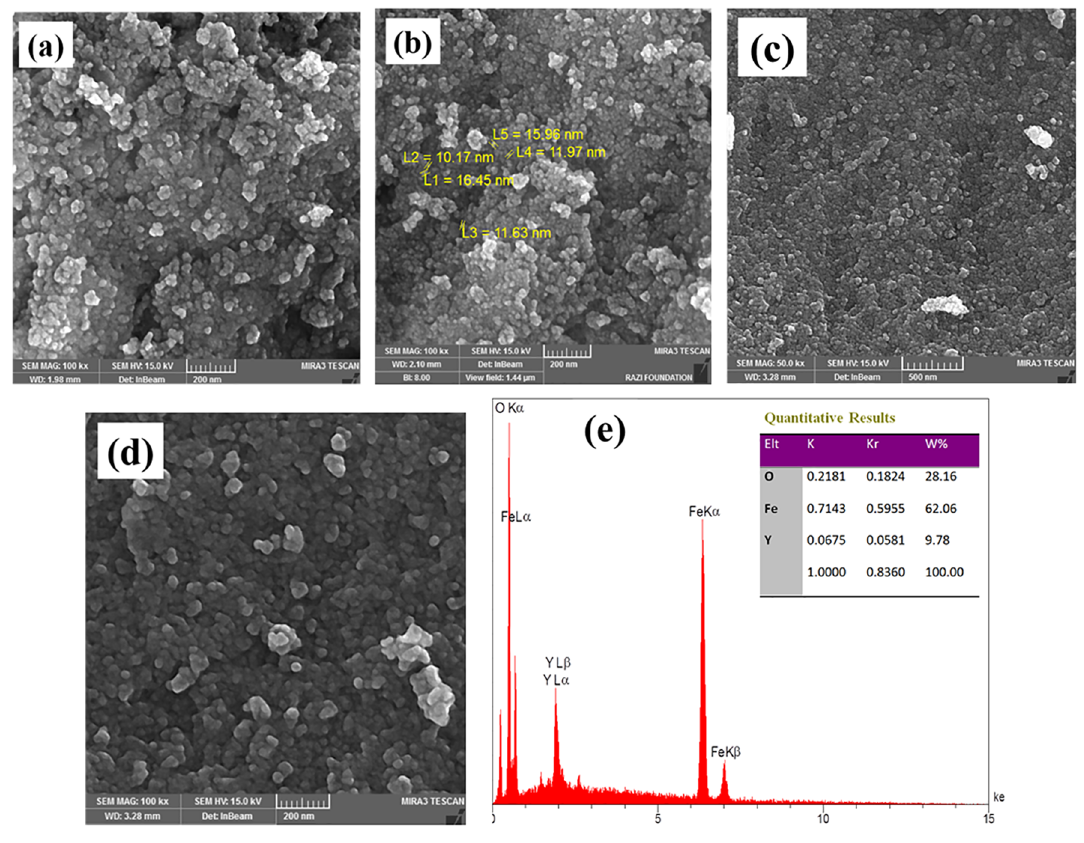
Fig. 3. FE-SEM images of (a,b) undoped and (c,d) Y 3+ doped iron oxide samples and (e) EDS analysis data